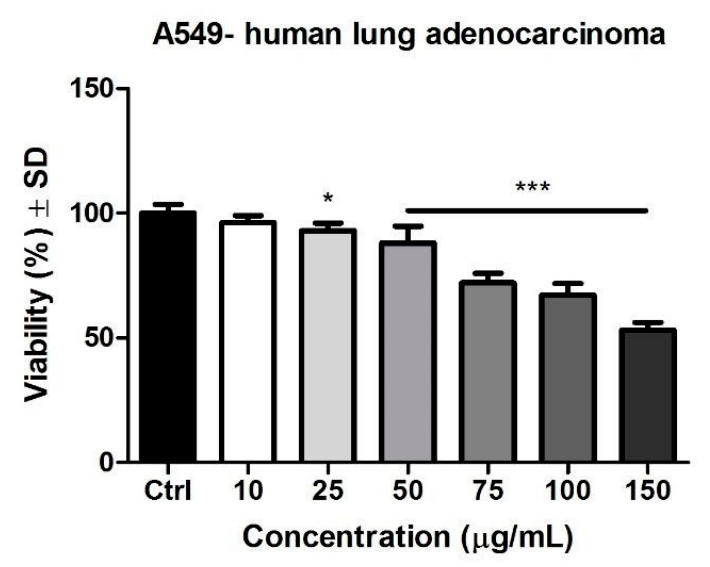
Figure 2. Pg (10, 25, 50, 75, 100, and 150 µ g/mL) effect on A549 human lung adenocarcinoma cells viability after 72 h stimulation. The data are expressed as cell viability percentage (%) related to the control cells. A one-way ANOVA test and Dunnett’s multiple comparison post-test were employed for comparison among groups (* p < 0.05, *** p < 0.001 vs. Control). Table 6. IC 50 values of Pg extract on A549 human lung adenocarcinoma cells at 72 h post-stimulation. Extract A549 IC 50 ( µ g/mL) Pg extract